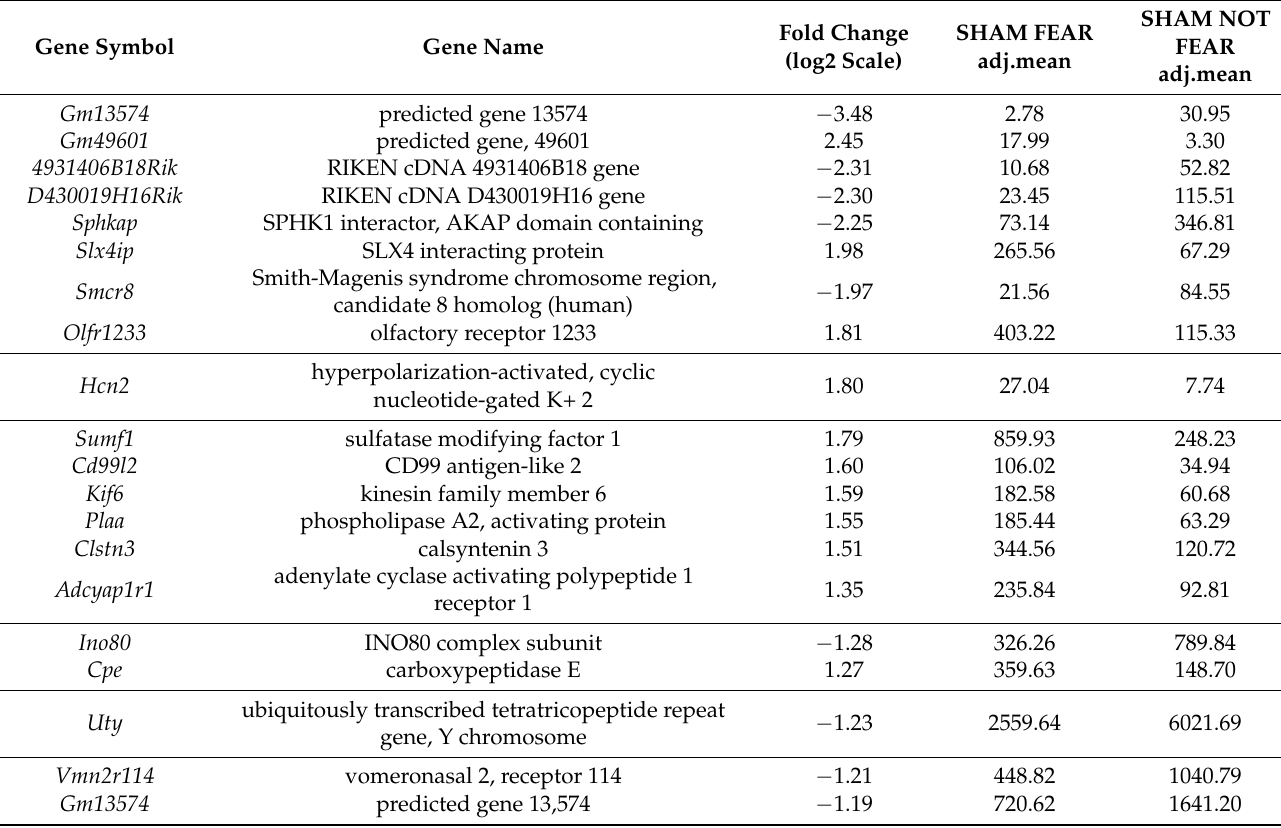
Table 4. The top 20 DEGs identified by differential expression profiling from RNA extracted by amygdala pyramidal neurons. Comparison between SHAM FEAR vs. SHAM NOT FEAR